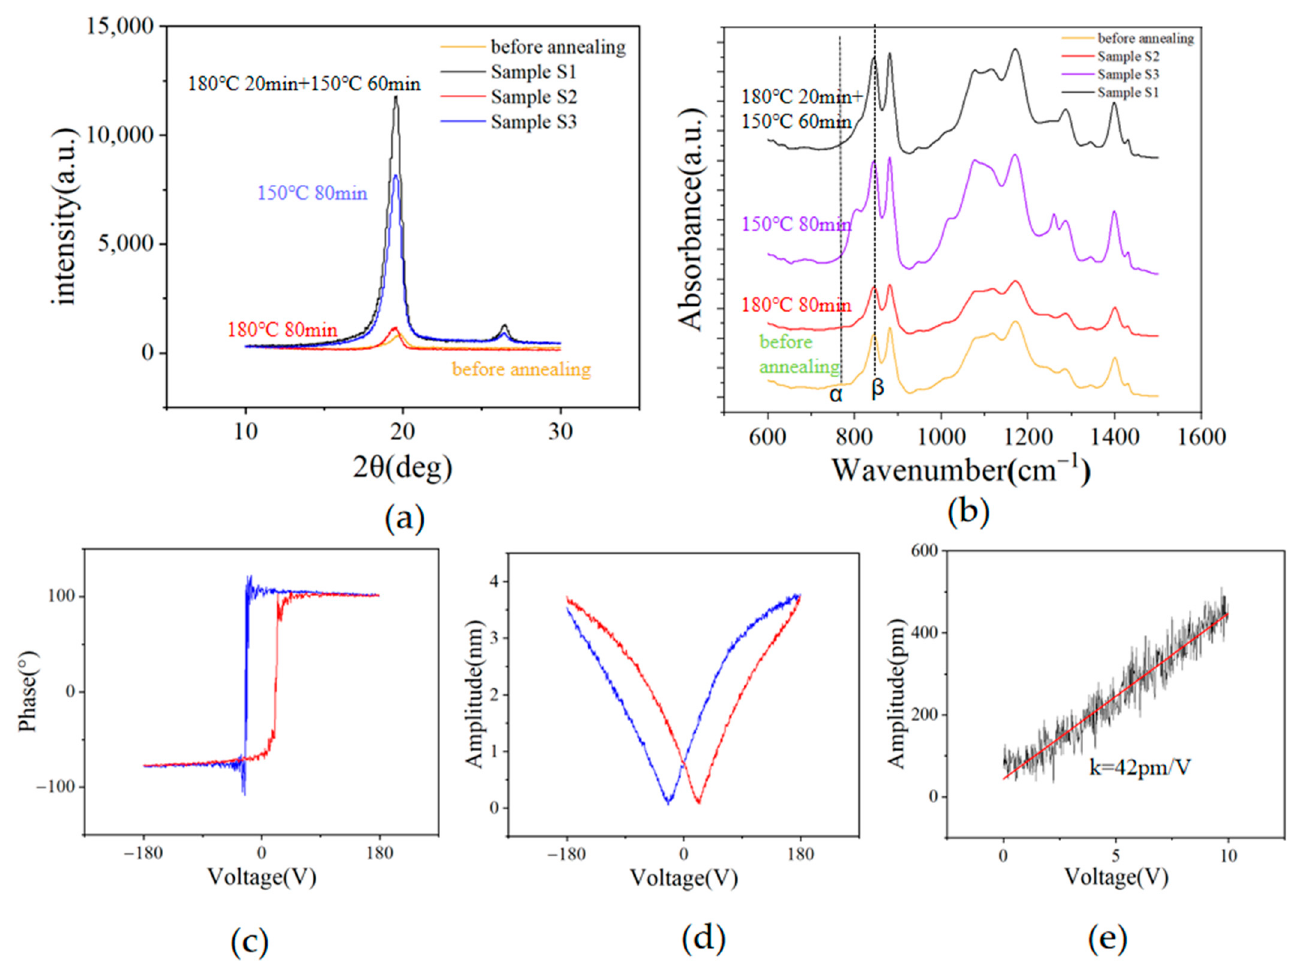
Figure 4. ( a ) XRD spectra; ( b ) FTIR spectra of the films with different annealing conditions; ( c ) phase and ( d ) amplitude curves of the piezoelectric response of the low-porosity P(VDF-TrFE) films under flip voltage; ( e ) the amplitude versus voltage curve when the voltage is less than the flip voltage, whose slope represents a d 33 of 42 pm/V.